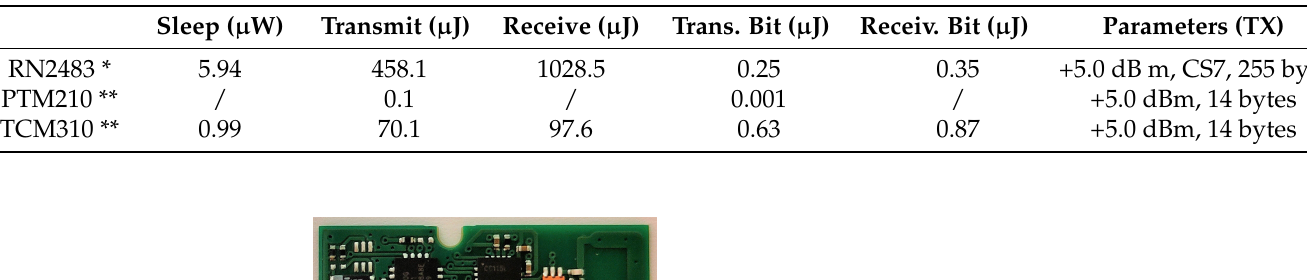
Table 7. Summary of the power consumption of different nodes. * LoRa technology, ** EnOcean technology.